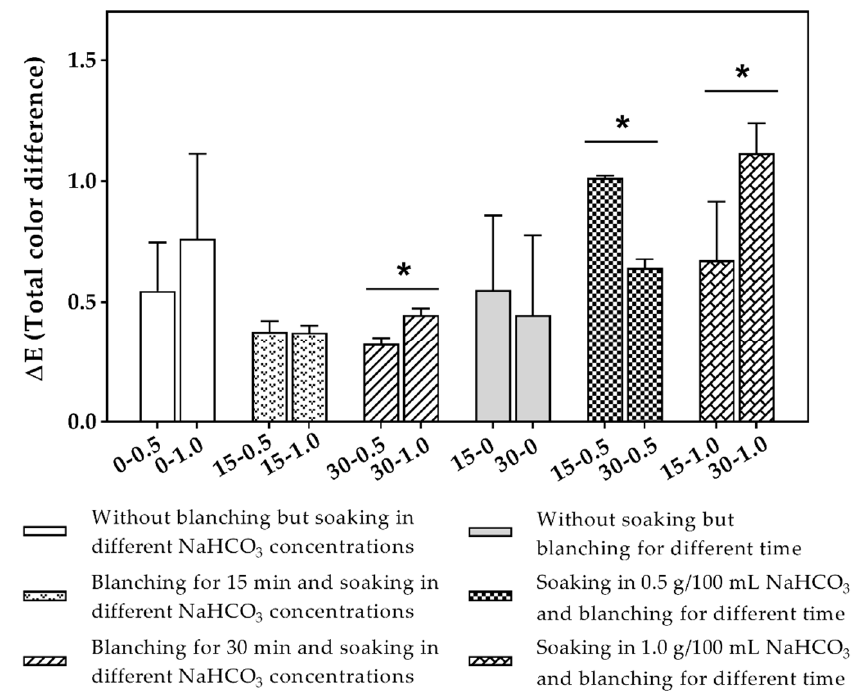
Figure 1. Total color difference between samples under different treatments and the corresponding control. (Labels mode of each column: blanching time-concentration of NaHCO 3 in soaking water, e.g., 15-0.5 means blanching for 15 min and soaking in water containing 0.5 g/100 mL NaHCO 3 . * Significant ( p < 0.05) difference between samples.).